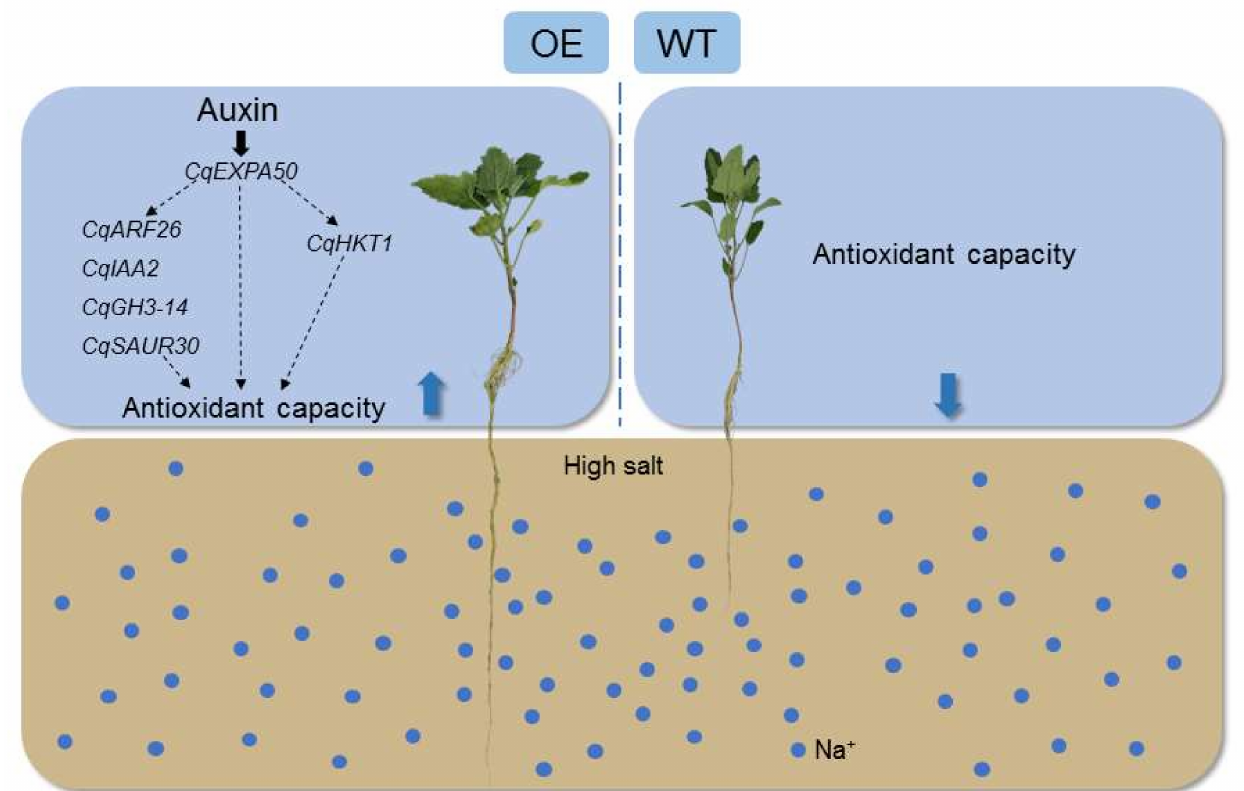
Figure 10. A proposed model to illustrate how CqEXP50 , CqARF26 , CqIAA2 , CqGH3-14 , CqSAUR30 and CqHKT1 enhance salt tolerance of quinoa seedlings. Blue dots represent Na+. The blue arrow up represents improvement and the blue arrow down represents reduction. CqEXP50 , CqARF26 , CqIAA2 , CqGH3-14 , CqSAUR30 and CqHKT1 can improve the antioxidant capacity of quinoa seedlings under salt